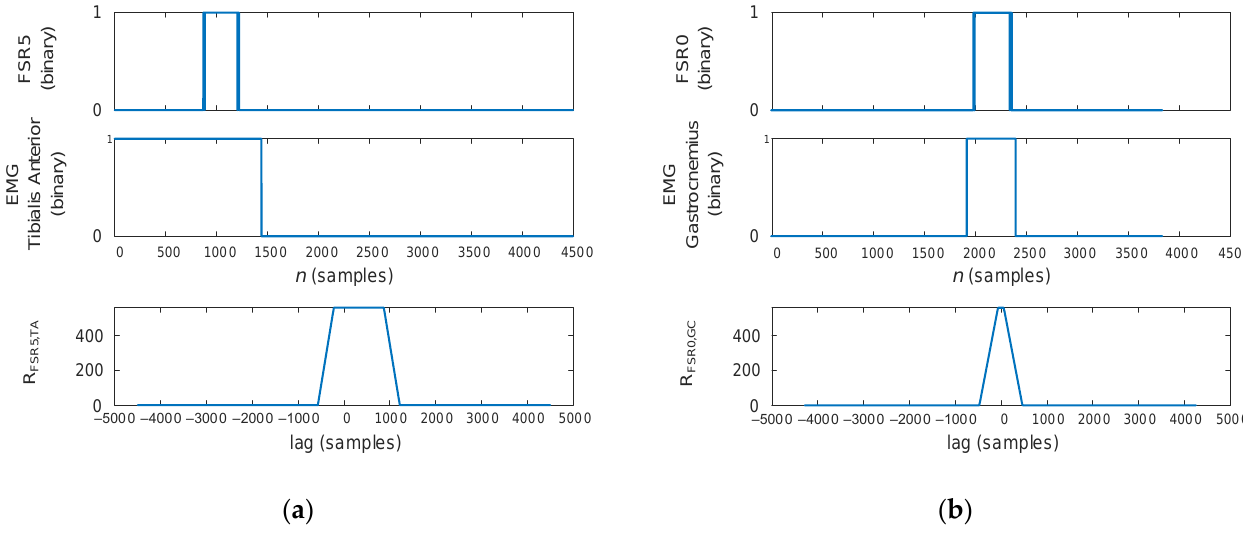
Figure 14. Illustration of the FSR and EMG interdependency via the cross-correlation of the binarized FSR reading and EMG activation which exhibits a maximum in the origin: ( a ) FSR 5 and tibialis anterior at heel strike, and ( b ) FSR 0 and gastrocnemius at toe-off.